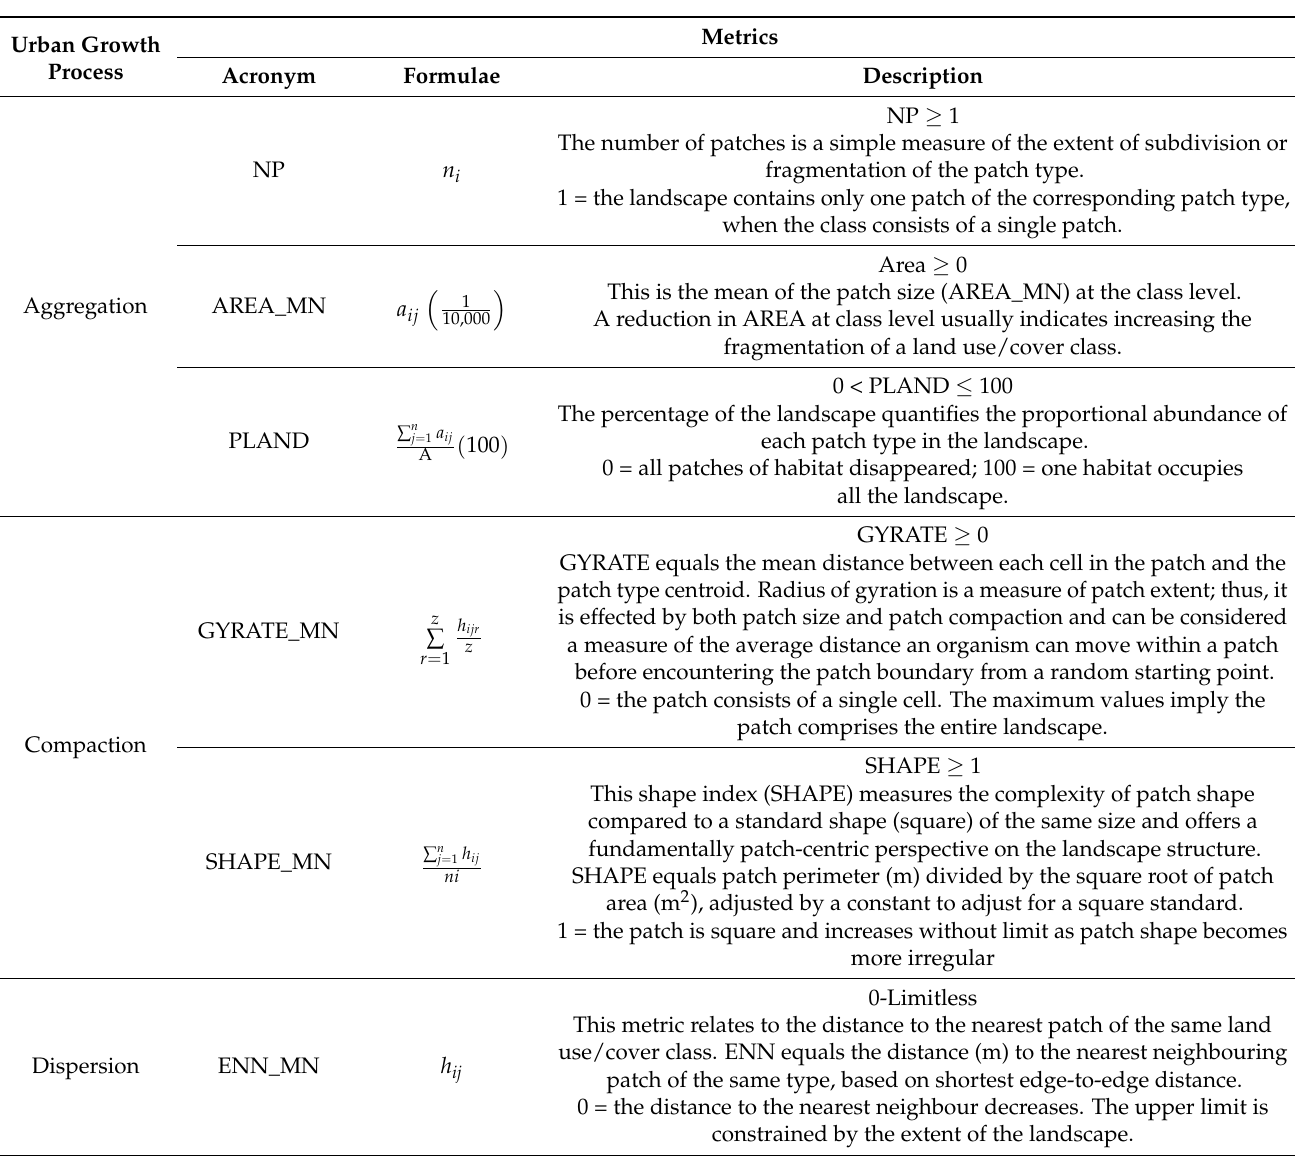
Table 2. Detailed description of the set of metrics